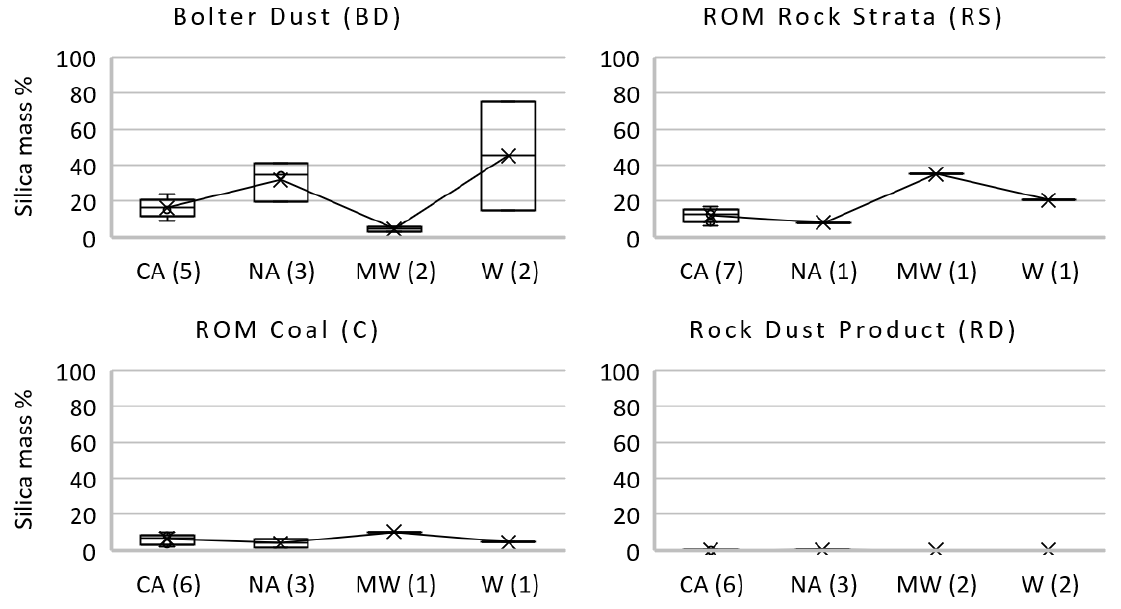
Figure 2. Distribution of silica mass% estimated from SEM-EDX for the respirable dust samples generated from primary source materials. Plots are shown by mine region for each material type. Number of samples per mine region are given in parentheses.